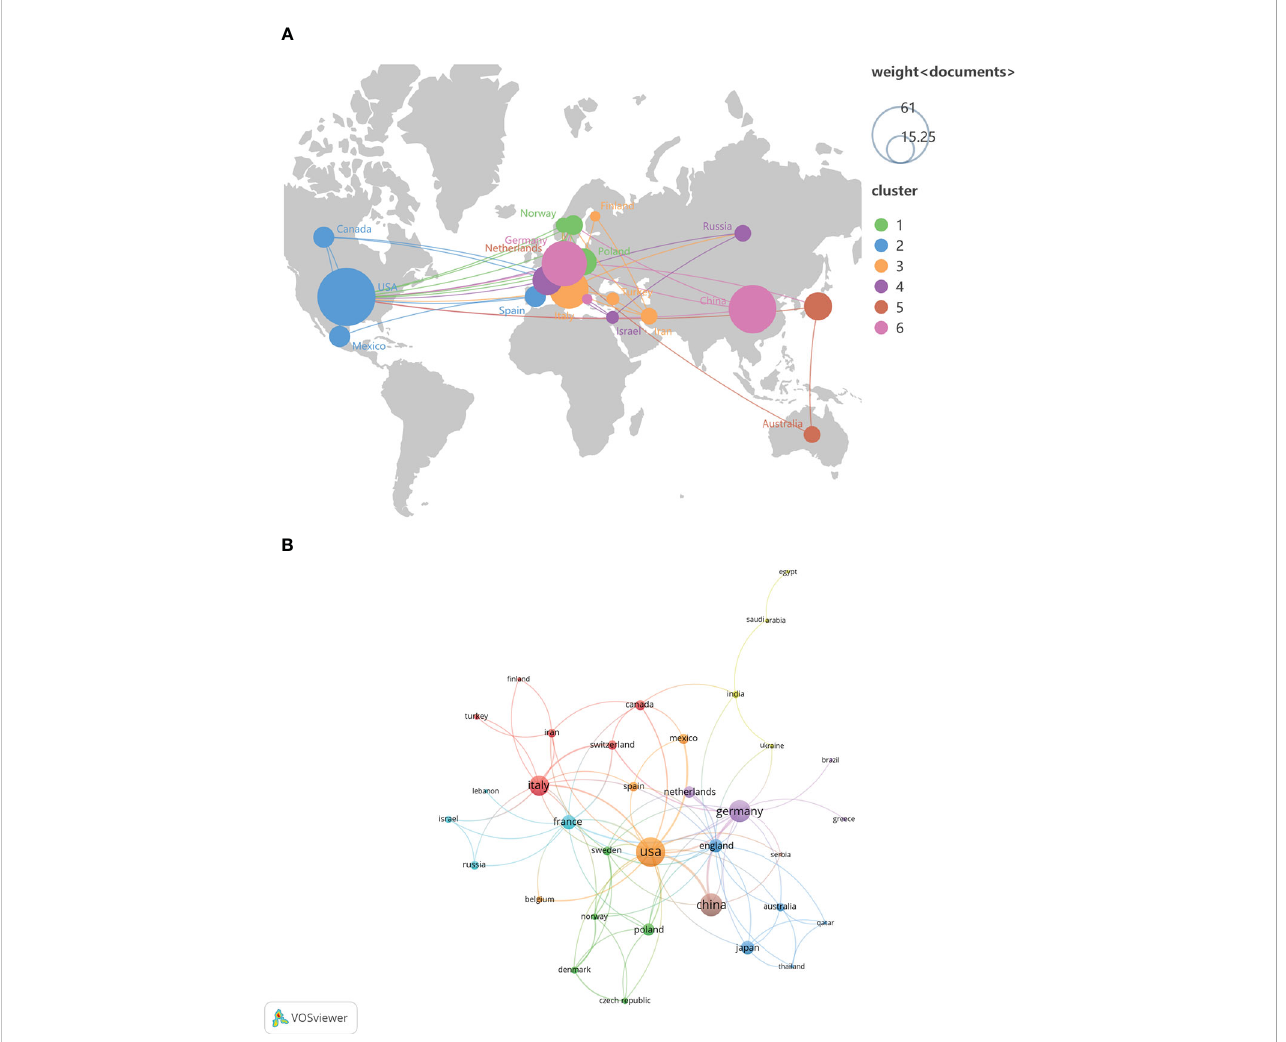
FIGURE 3 The geographical distribution (A) and visualization of countries (B) on the research of NETs in